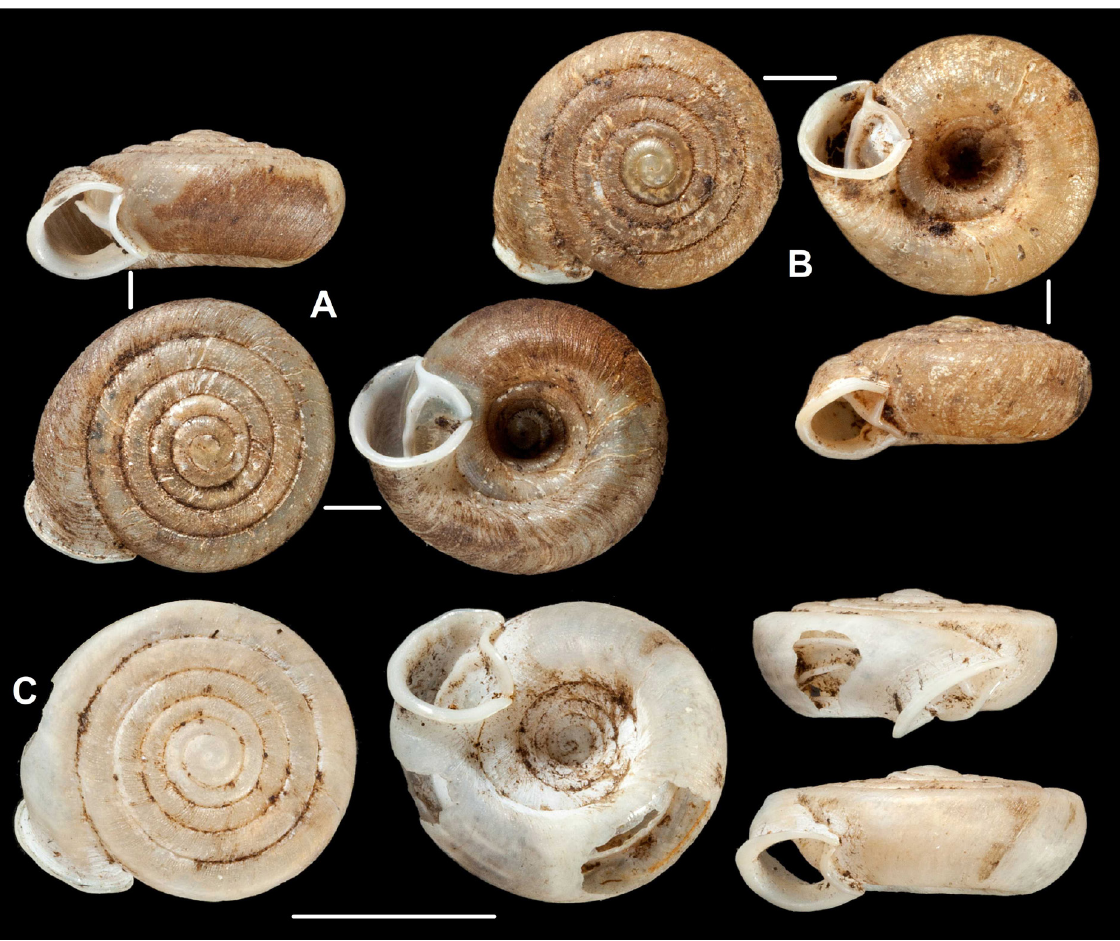
Fig. 30. Shells of species of Chersaecia Gude, 1899. A . C. shiroiensis shiroiensis (Godwin-Austen, 1875), syntype (NHMUK 1903.7.1.747). B . C. shiroiensis subnagaensis subsp. nov., holotype (NHMUK 1903.7.1.753.1). C . C. woodthorpei (Gude, 1899) comb. nov., syntype (NHMUK 1903.7.1.2100). Scale bar = 5 mm. All photos: H.